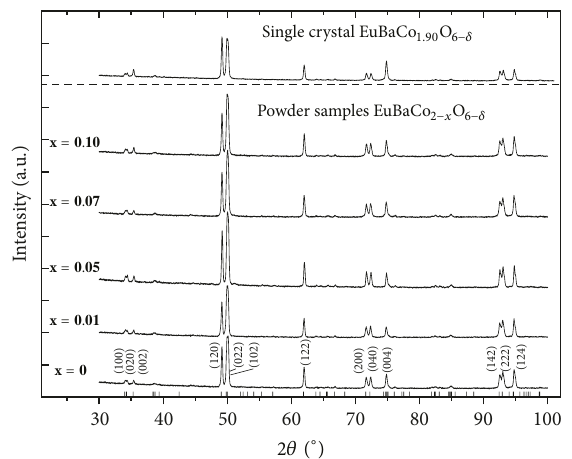
Figure2:XRDpatternsofthepowdersamplesofdoubleperovskites EuBaCo 2− O 6−𝛿 ( 𝑥 = 0, 0.01, 0.05, 0.10) and ground single crystal x EuBaCo 1.90 O 6−𝛿